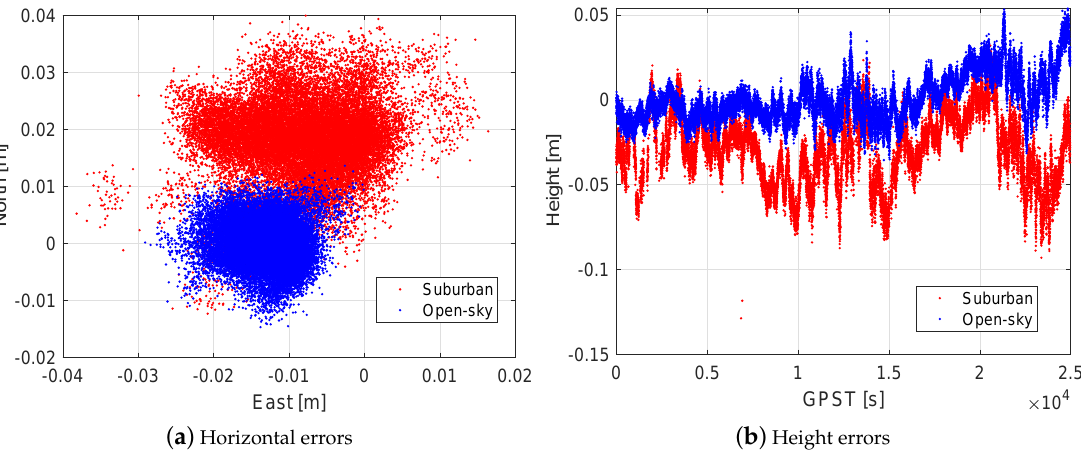
Figure 7. Ambiguity-fixed positioning errors in ( a ) the horizontal plane and ( b ) the vertical direction during T1 for the open-sky and the suburban